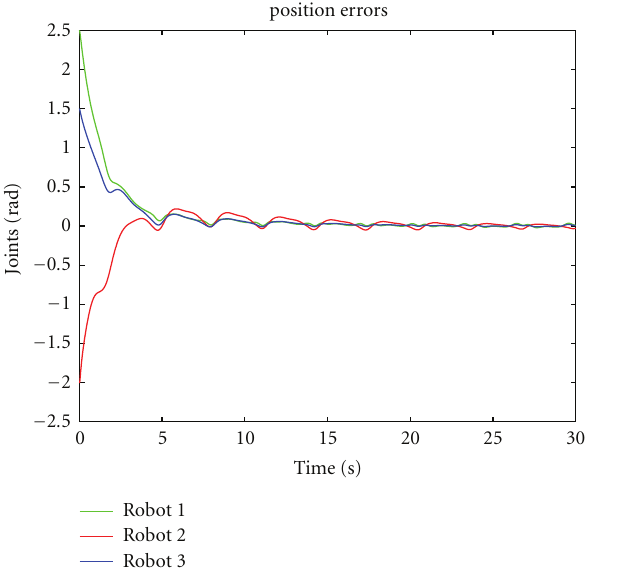
Figure 4: Position errors: adaptive synchronization.